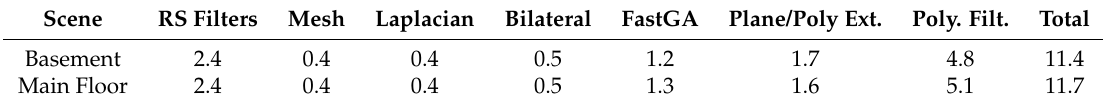
Table 8. Mean execution timings (ms) of Polylidar3D with RGBD data collected from indoor settings. Scene RS Filters Mesh Laplacian Bilateral FastGA Plane/Poly Ext. Poly. Filt. Total